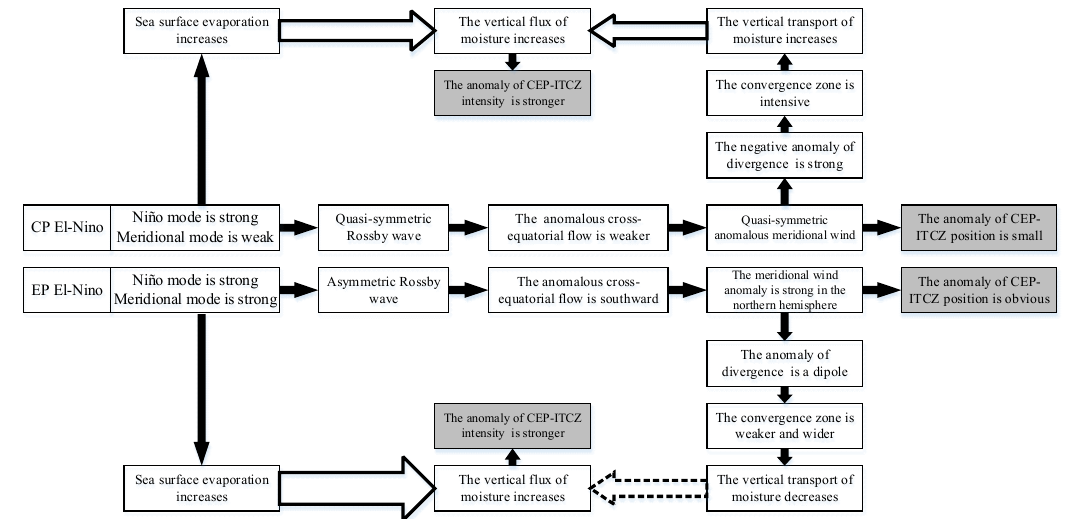
Figure 12. The possible mechanism of two types of El Niño affecting the position and intensity of the CEP-ITCZ (the width of the hollow arrows represents the relative strength of the effect, the solid lines represent a promotion effect, the dotted line represents an inhibitory effect, and the solid arrows have no special